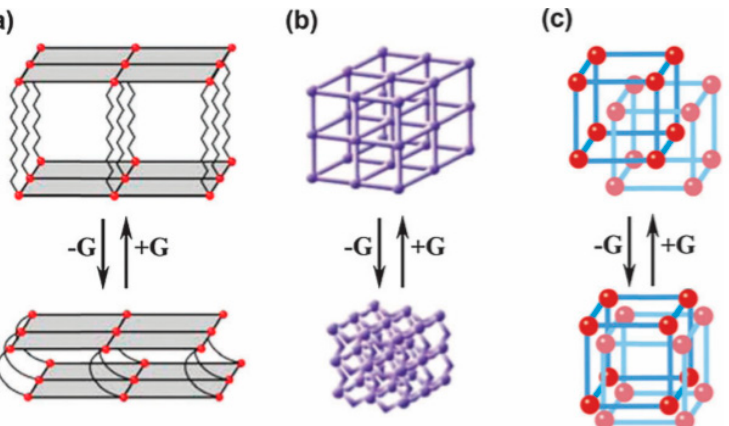
Figure 7. Three classes of breathing in dynamic 3D MOFs categorized by Kitawaga and Uemura. ( a )